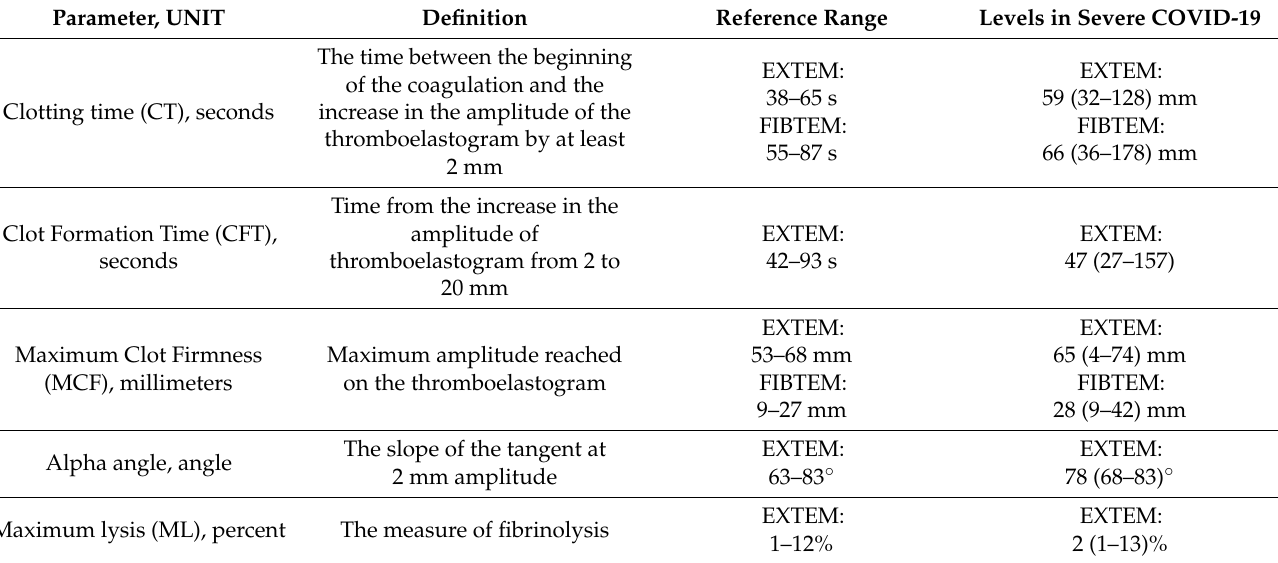
Table 2. Results of rotational thromboelastometry (ROTEM) in severe COVID-19 patients.